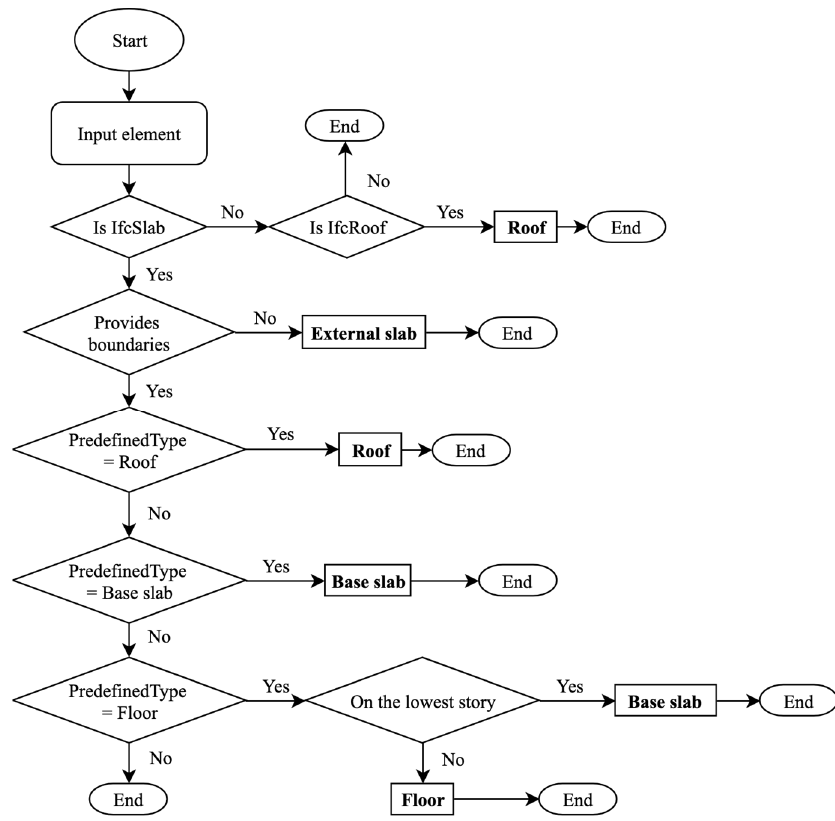
Figure 7. Decision tree for determining slab types, i.e., base slabs, floors, external slabs and